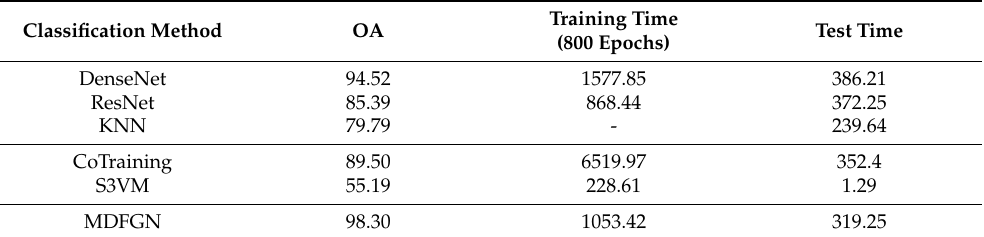
Table 4. Time consumed (s) for training and validation of different